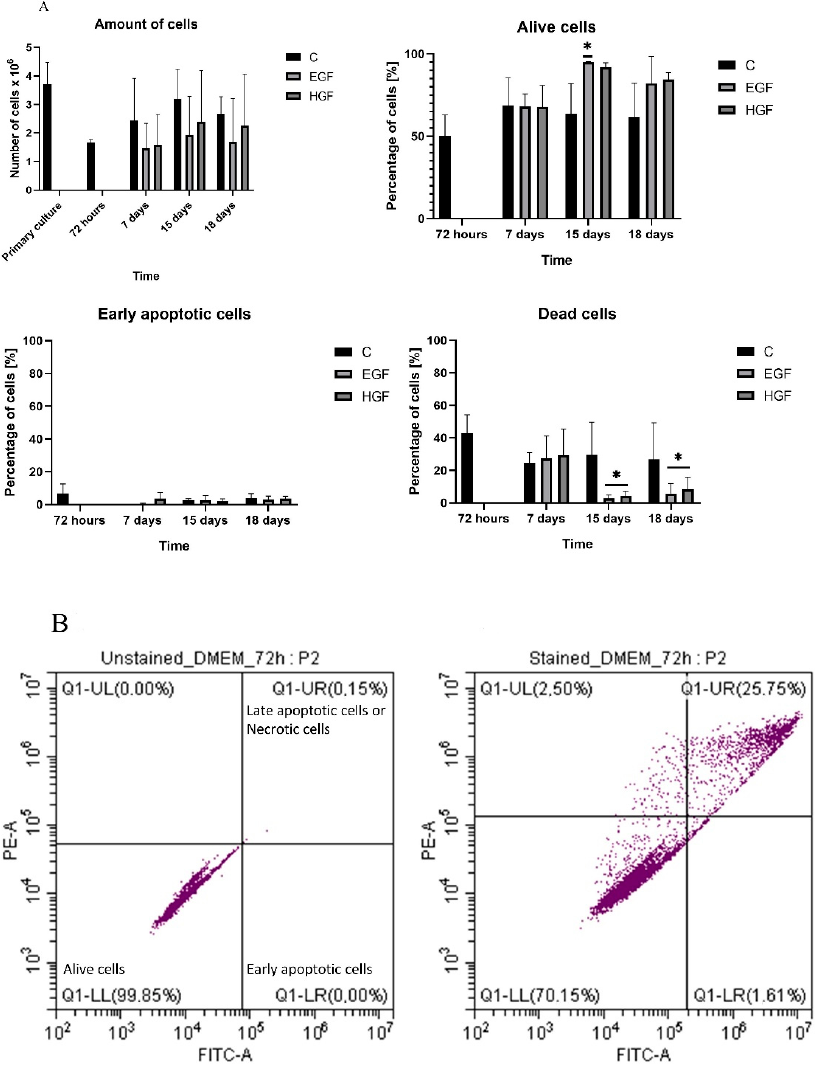
Figure 2. ( A ) The cell count and viability of hAECs in the control culture (C) and in the test groups (EGF and HGF) expressed as the percentage of viable cells—negative for annexin and propidium iodide; cells in early apoptosis—annexin-positive and propidium-iodide-negative cells; and dead cells—positive for both dyes. The mean number of seeded cells in each of the test groups was 3.7 million. * = statistically significant relative to control cells at 72 h ( p < 0.05); n = 3. ( B ) The representative flow-cytometry histogram taken from control group at 72 h of culture shows the distribution of alive (LL), early apoptotic (LR), and late apoptotic/necrotic cells (UR). Left picture—unstained cells, right picture—stained cells.